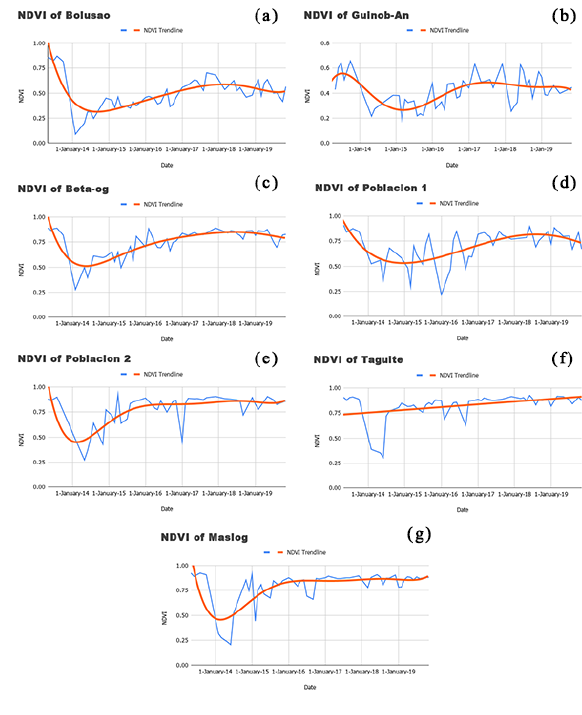
Figure 8. NDVI time series charts showing the general trend of mangrove growth for each coastal barangay of Lawaan (a) Bolusao, (b) Guinob-an, (c) Beta-og, (d) Poblacion I, (e) Poblacion II, (f) Taguite, (g) Maslog